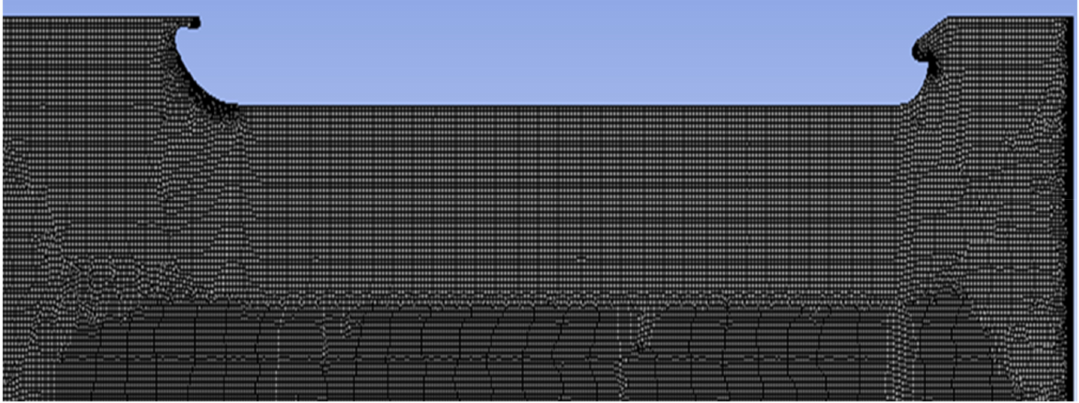
Figure 1. Meshed non-air lubrication geometry.